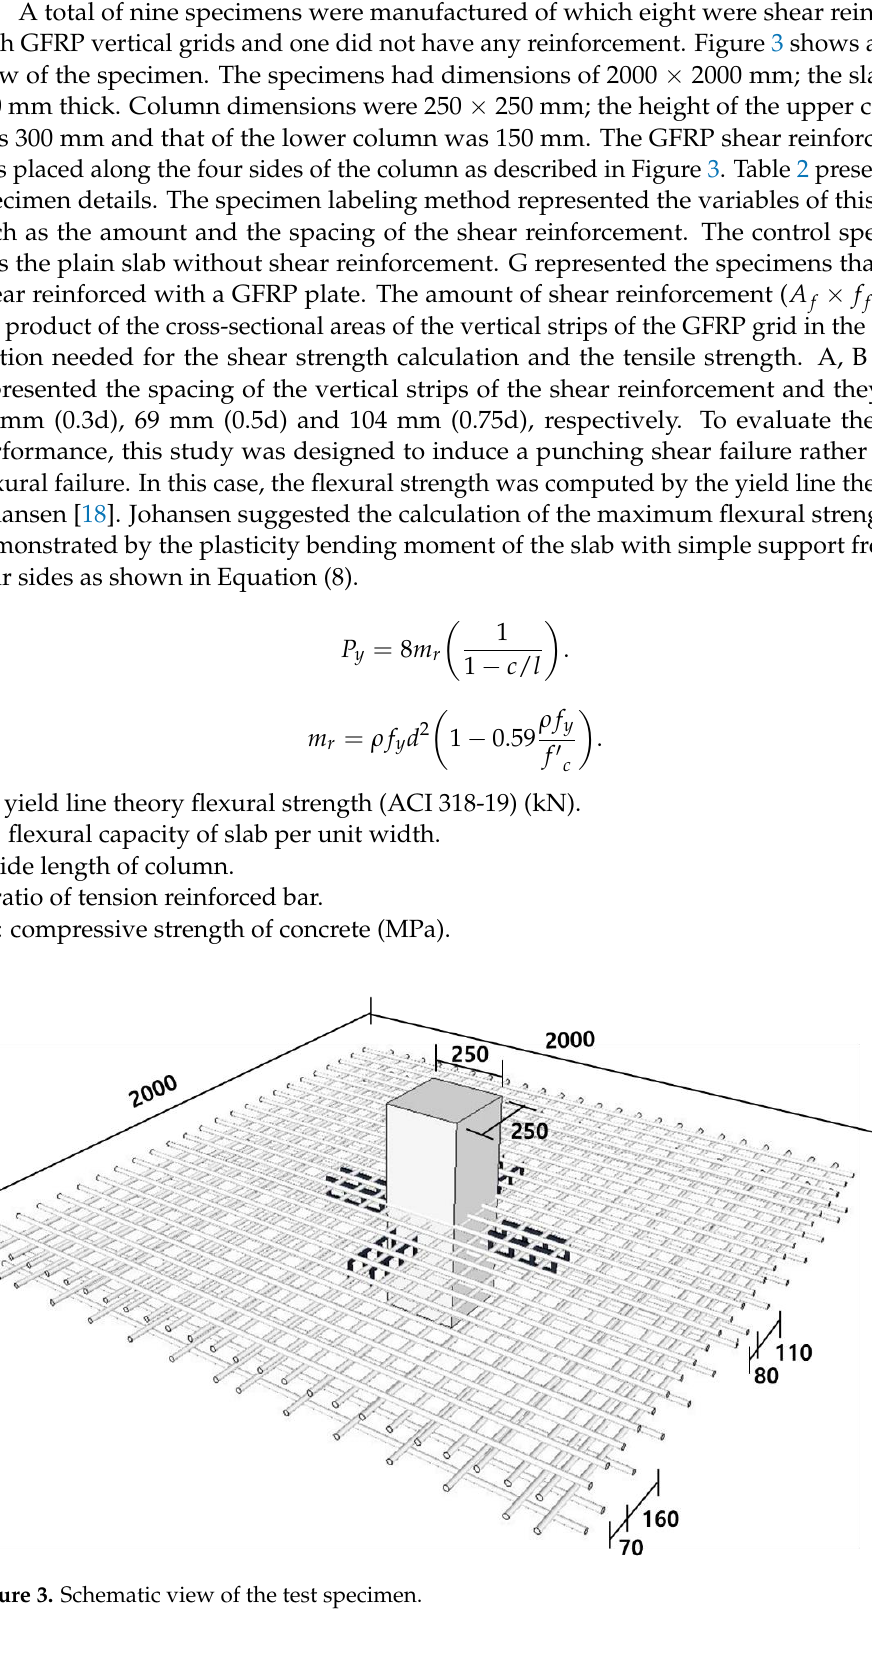
Table 1. Material properties.